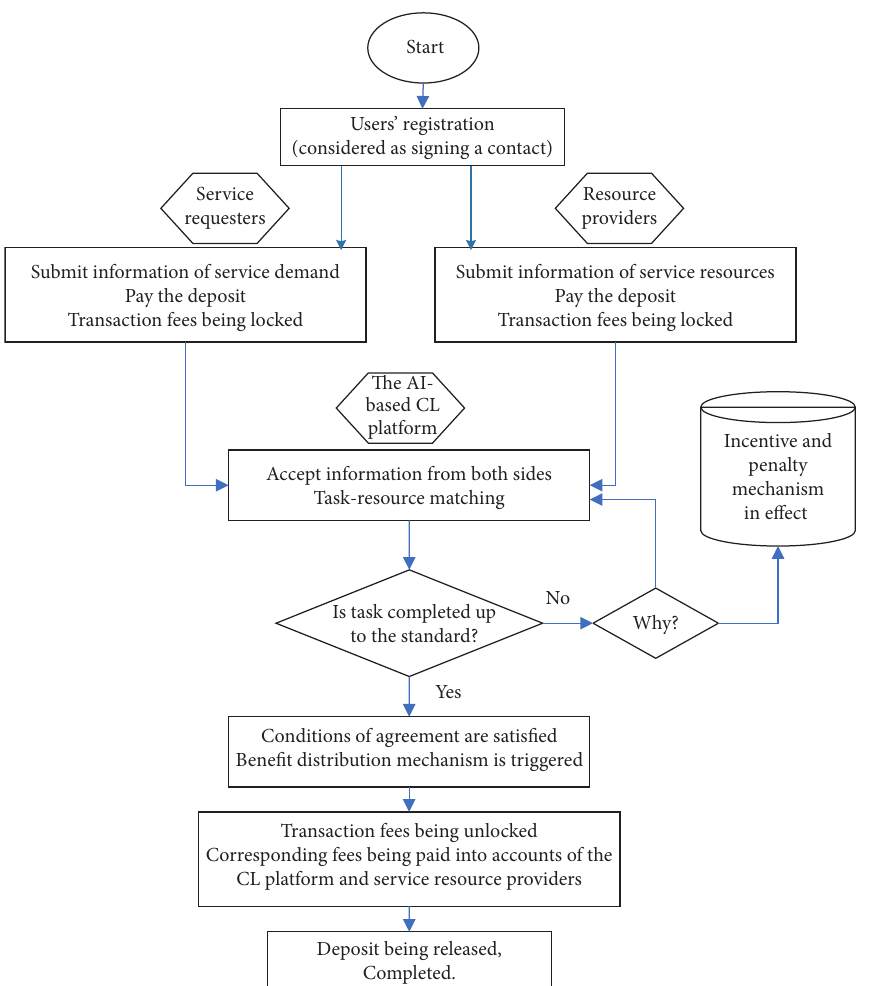
Figure 3: Execution procedures of the smart contract for the AI-based CL